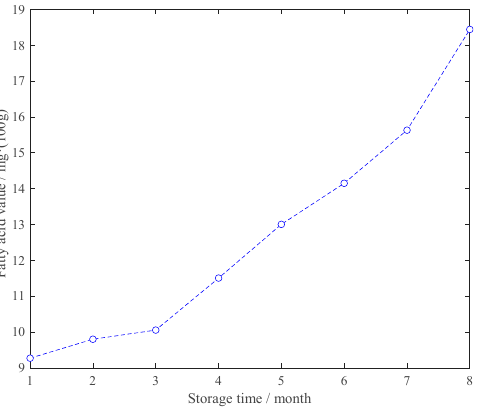
Figure 2. The variation trend of the fatty acid values of the rice samples in different storage periods.